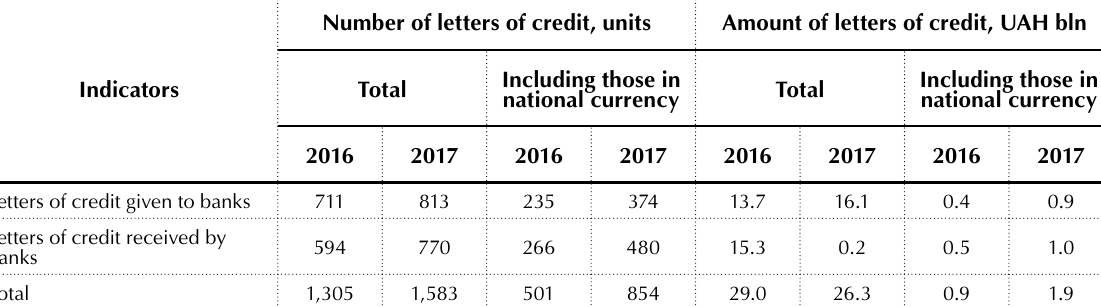
Table 3. Letters of credit transactions of Ukrainian banks in the period 2016–2017 (at the beginning of the